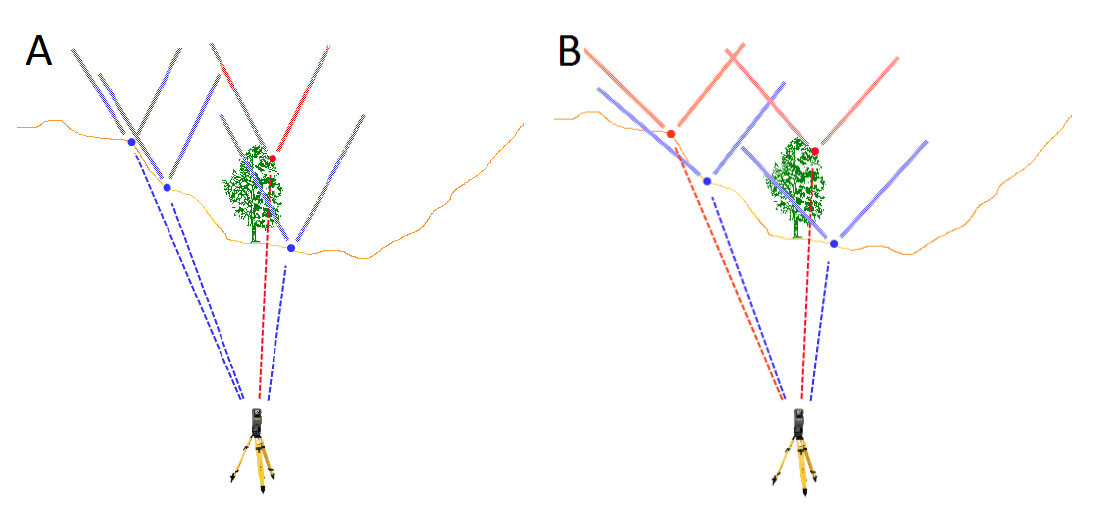
Figure 2. Frontal view of a terrestrial laser scan recording. Marked is the V-shaped elimination area. The blue dots are further away from the laser scanner than the red dots. Part A shows a larger filter angle than part B